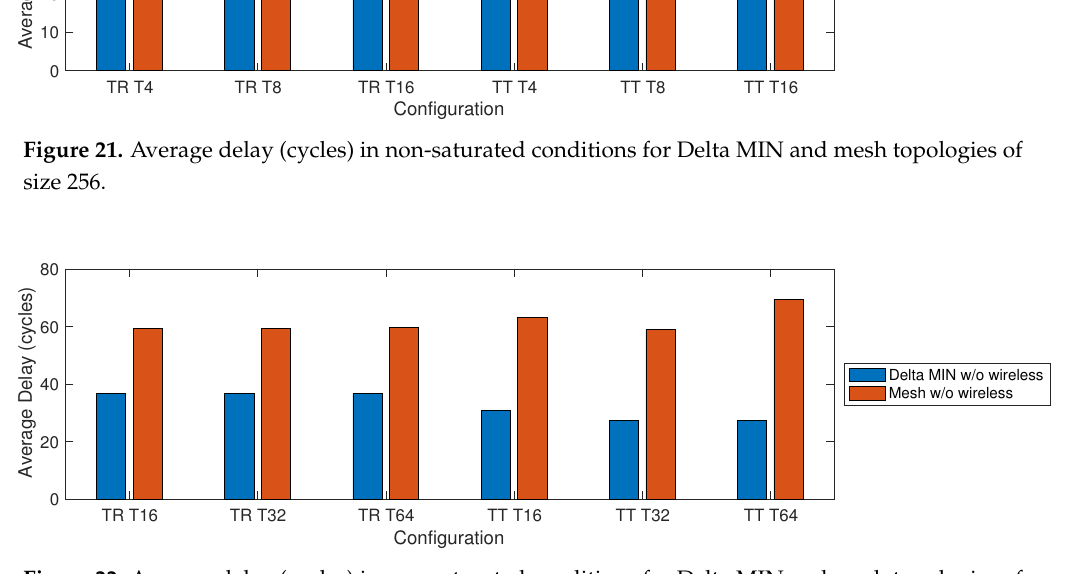
Figure 22. Average delay (cycles) in non-saturated conditions for Delta MIN and mesh topologies of size